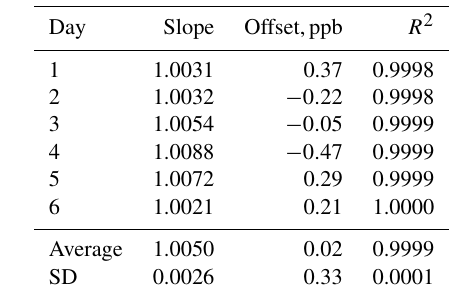
Table 1. Results of a US EPA “6 × 6” calibration of the Model 306 Ozone Calibration